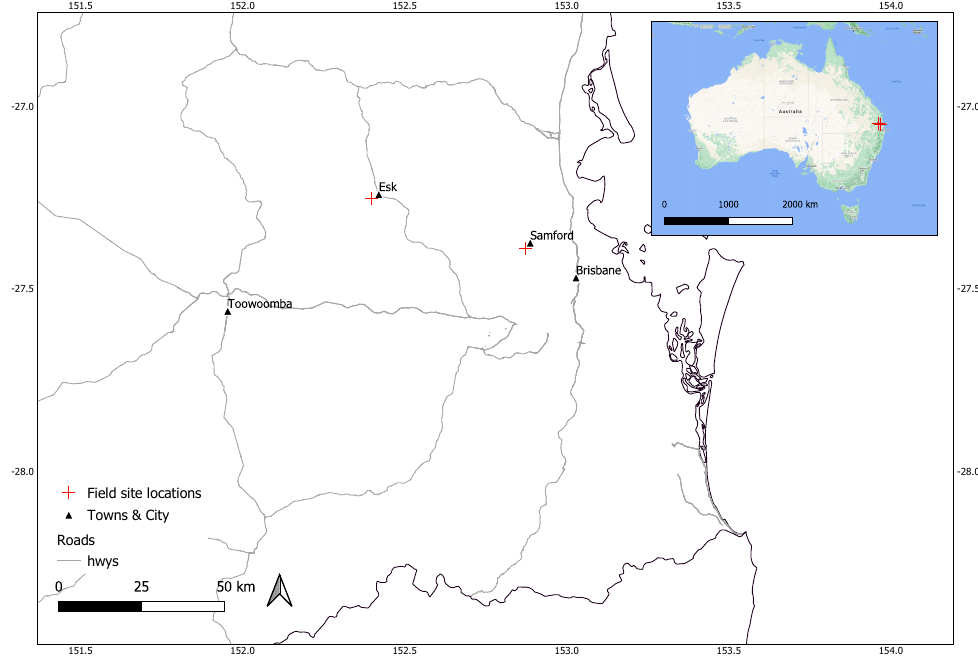
Figure 1. Location of study area in relation to South East Queensland and Australia.